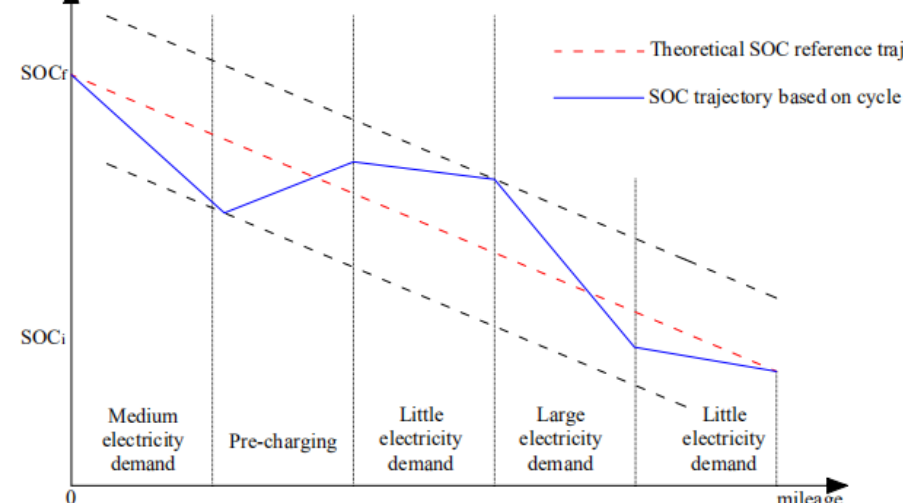
Figure 7. Schematic of SOC planning based on cycle.